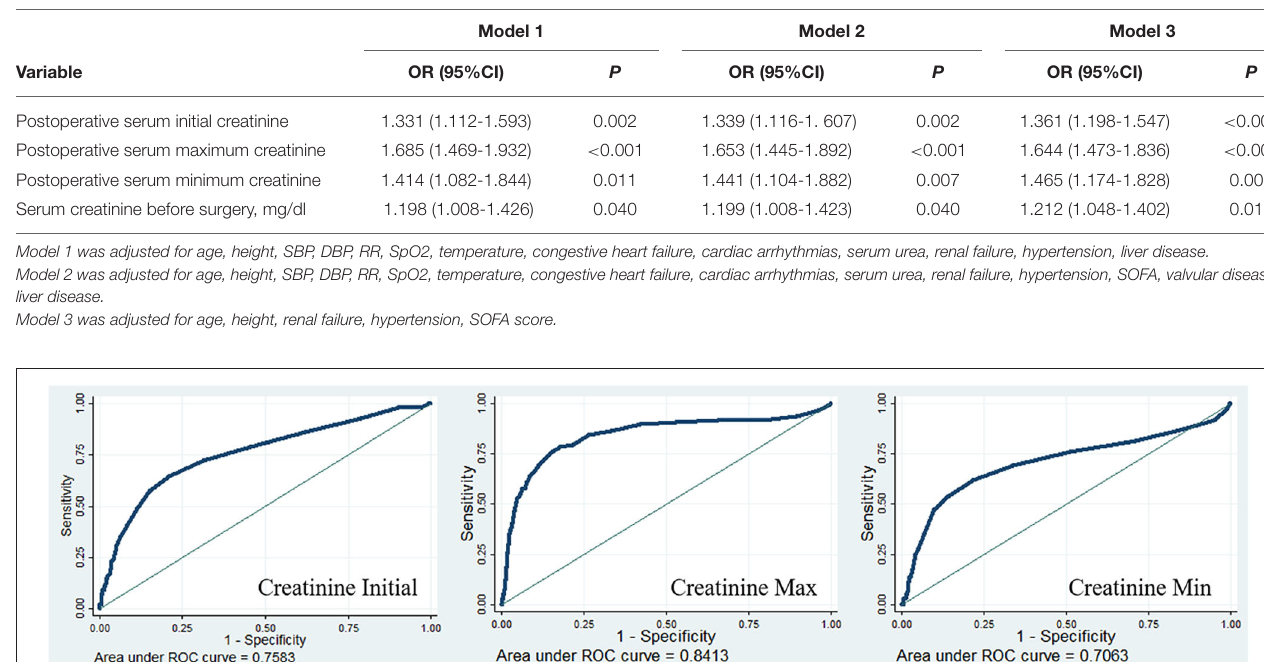
TABLE 5 | Multivariable logistic regression analyses for hospital mortality associated with serum creatinine in cardiac surgery patients.